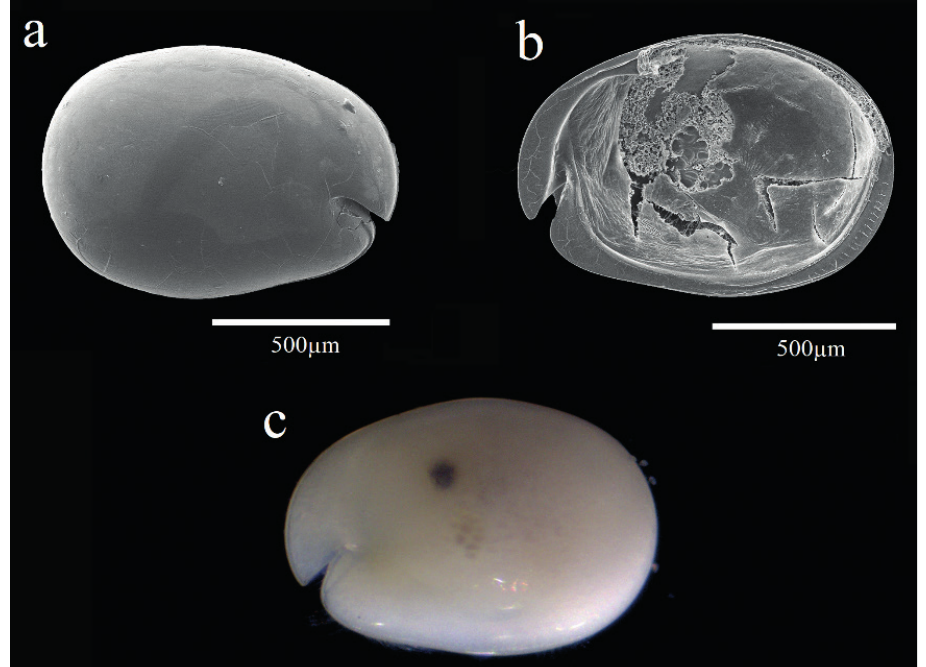
Figure 8. Light microscopy and scanning electron microscopy images of Parasterope singula sp. nov. holo- type female adult: a Lateral view from left valve b Internal view from left valve c External